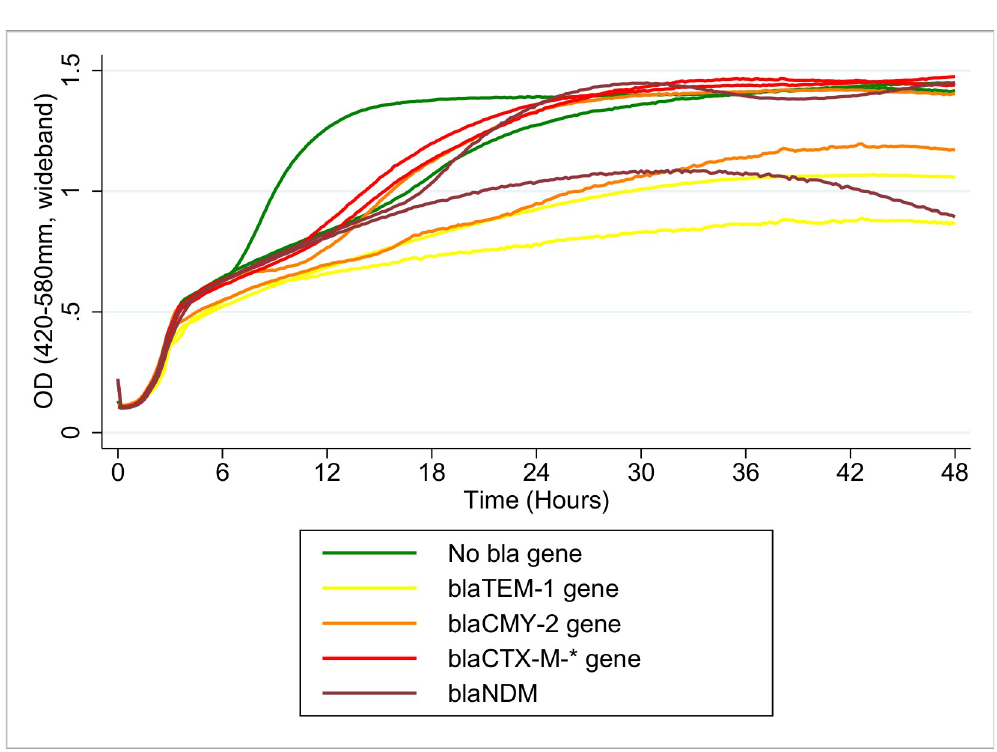
Fig 1. Raw optical density line plots for 10 individual strains a grown in cation-adjusted Mueller-Hinton II broth. (Green) E . coli strains lacking any beta-lactamase encoding genes, (Yellow) bla TEM-1 beta-lactamase encoding gene strains, (Orange) bla CMY-2 beta-lactamase encoding gene strains, (Red) bla CTX-M- � beta-lactamase encoding gene strains, and (Maroon) bla NDM/IMP/KPC carbapenemase encoding gene E . coli strains. a These same two selected strains per bla -gene group (color) were used in the multi-strain mixed-culture batch growth experiments.